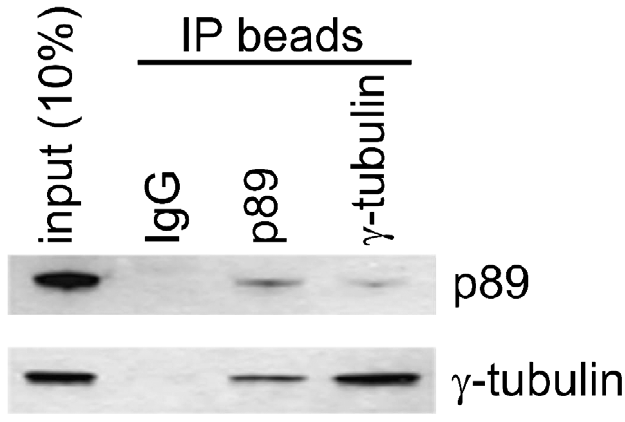
Fig. 3. p89 interacts with γ -tubulin. Immunoprecipitation with antibodies against p89 and γ -tubulin reveals a reciprocal co-immunoprecipitaiton, indicating an interaction between p89 and γ -tubulin. Mouse IgG: control antibody. rect (or indirect) physical interaction between p89 and centrosomal components (Fig.